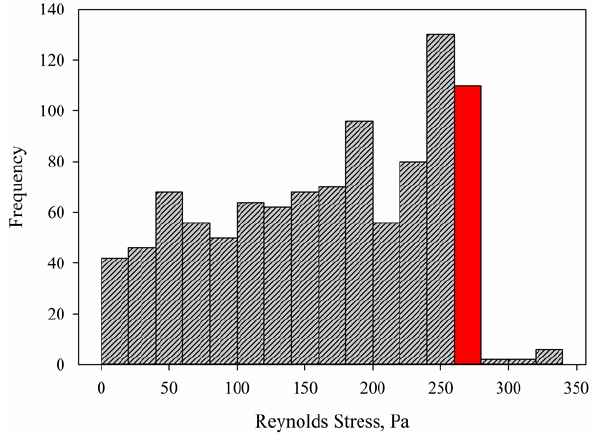
Figure 7. Frequency of Reynolds stresses in capillary tube for the case whereby τ 𝑤 = 400 Pa.